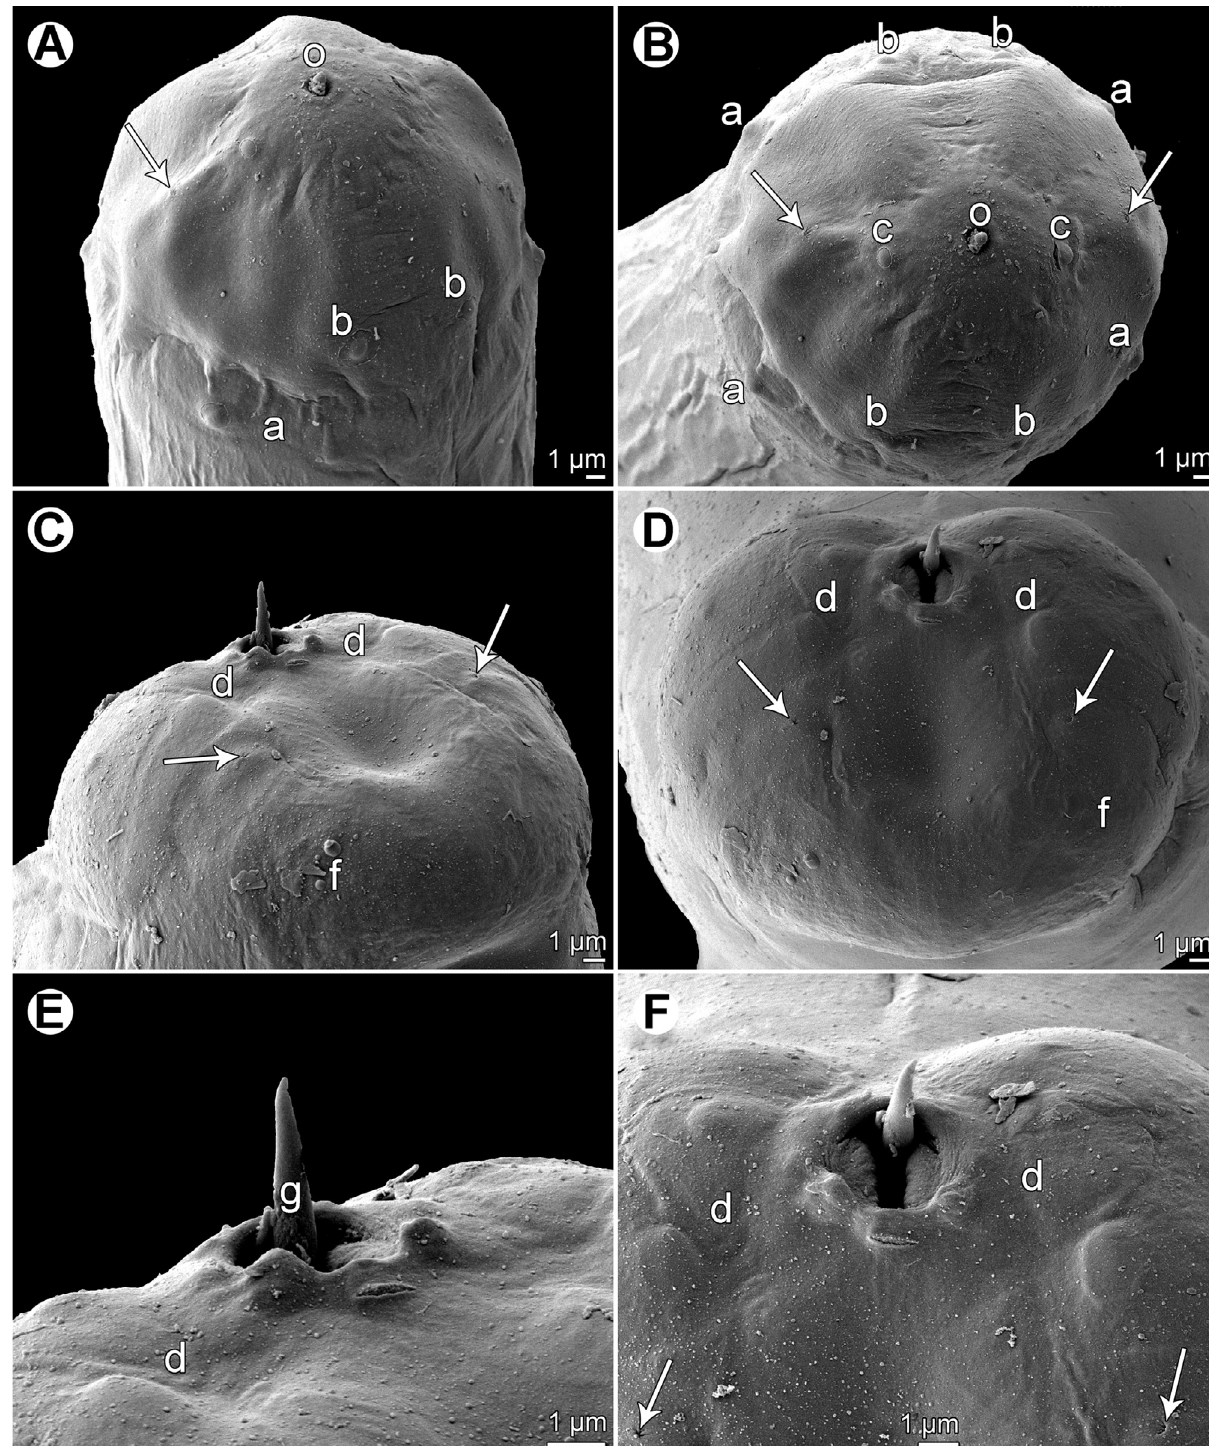
Figure 9. Philometra selaris n. sp. from Selar crumenophthalmus , scanning electron micrographs of male. A, B: Cephalic end, sublateral and apical views (arrows indicate amphids). C, D: Caudal end, subdorsal and apical views (arrows indicate phasmids). E, F: Region of cloacal aperture, lateral and apical views (arrows indicate phasmids). Abbreviations : a, submedian pair of cephalic papillae of external circle; b, submedian cephalic papilla of internal circle; c, lateral cephalic papilla of internal circle; d, pair of larger caudal papillae near cloacal aperture; f, caudal mound; g, gubernaculum; o, oral